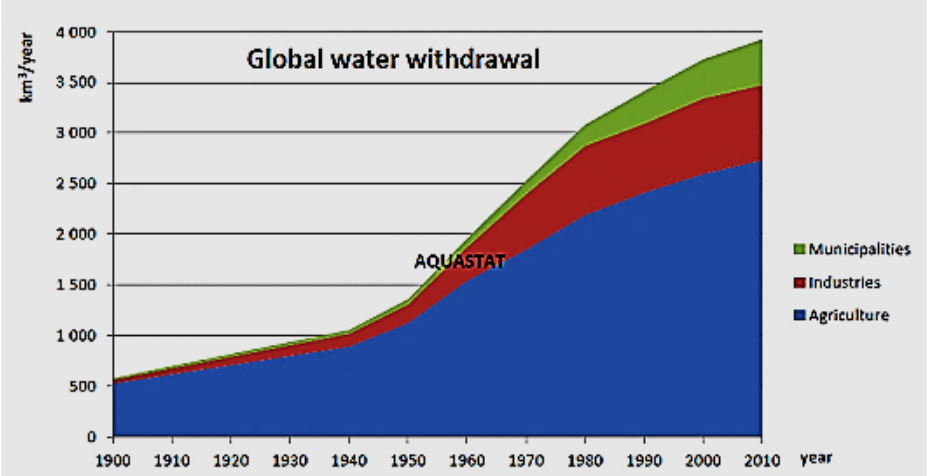
Figure 17. Global water withdrawal over time. Table 3. Evolution of water withdrawal by section in DRC (million m 3 ).